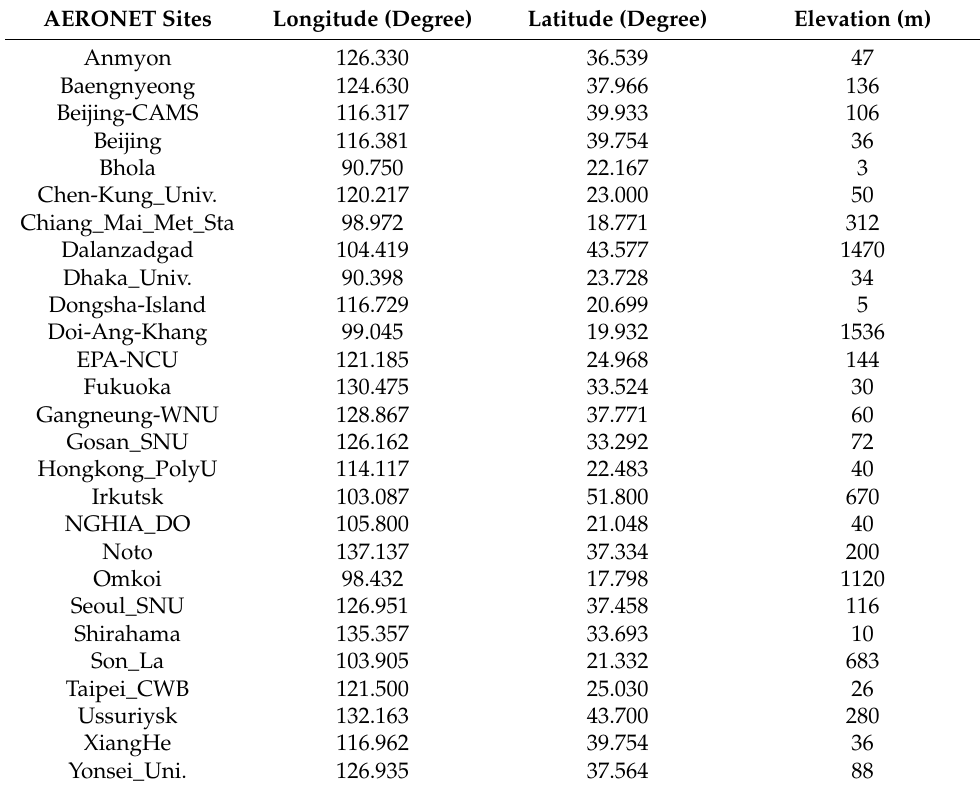
Table 2. AERONET site